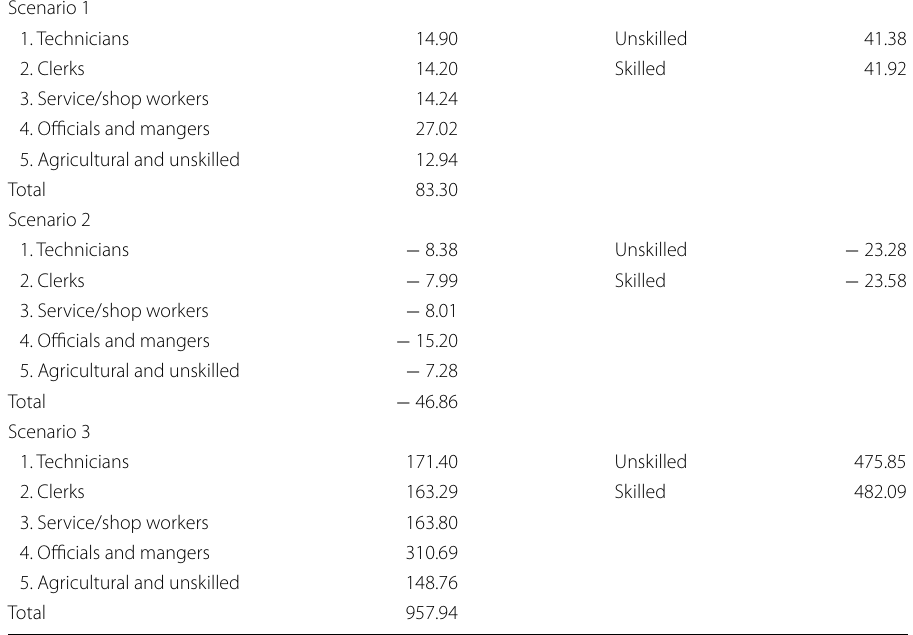
Table 12 Additional labour force generation in different scenarios with USA (in thousand) Scenario